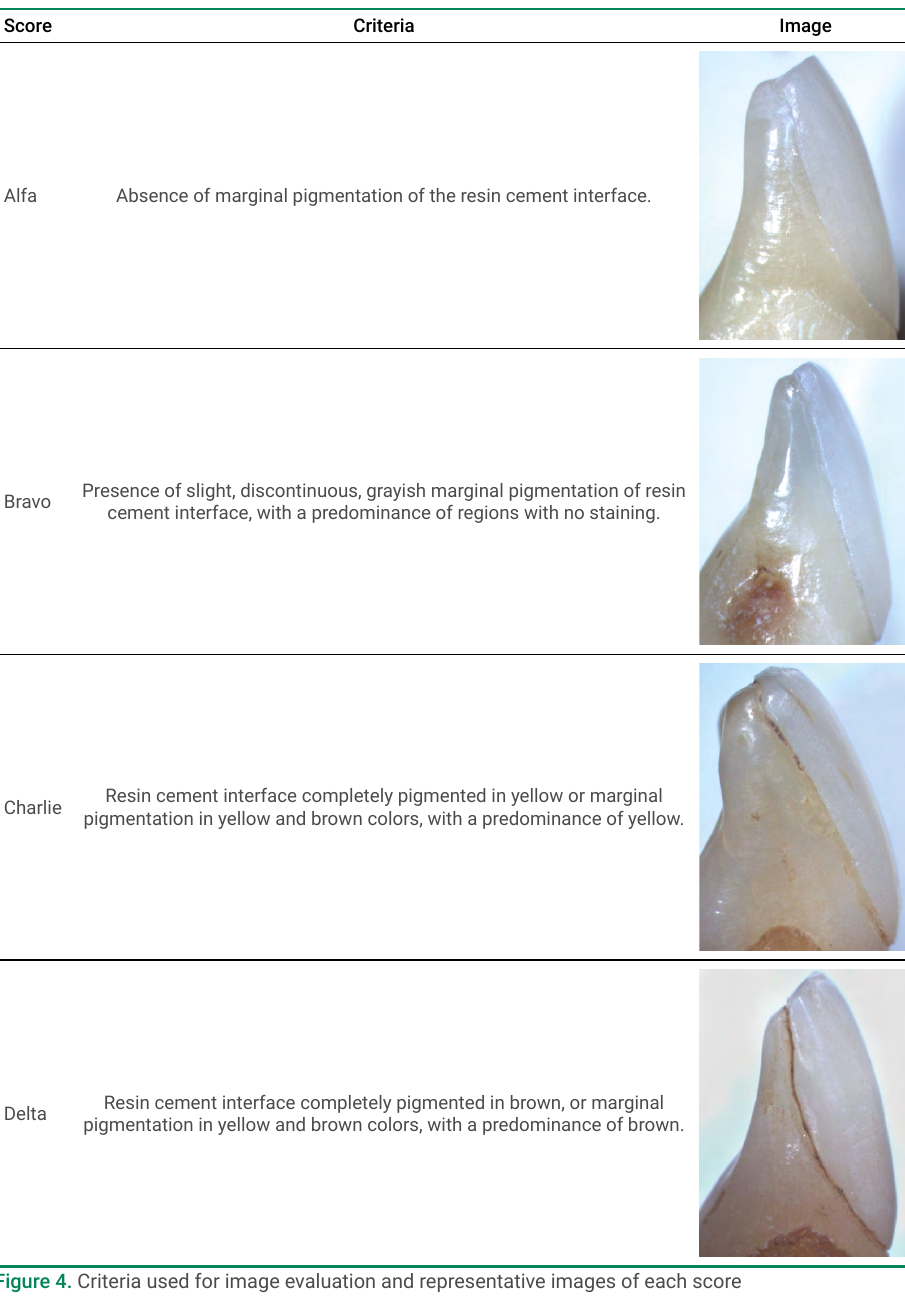
Figure 4. Criteria used for image evaluation and representative images of each